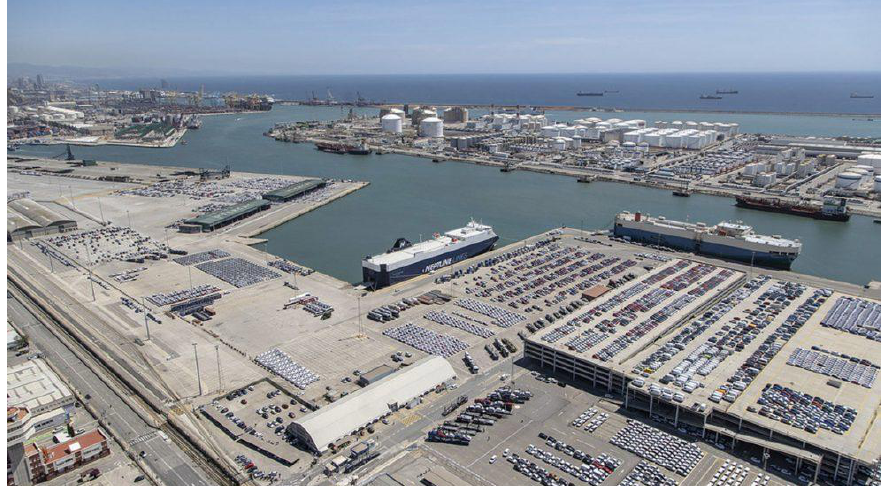
Figure 3. View of the South basin of Barcelona port. Source: elmercantil.com, (accessed on 14 March 2022).